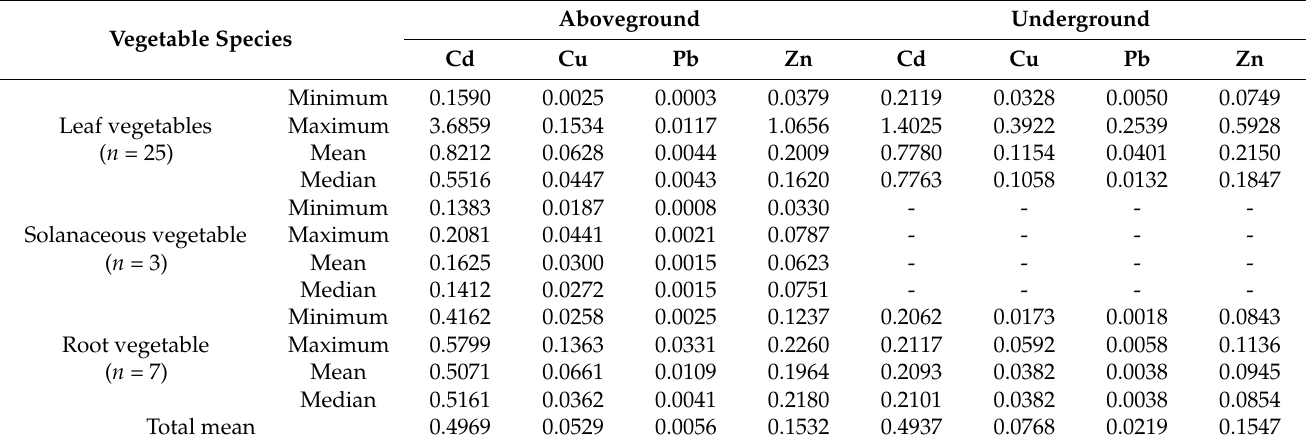
Table 4. Bioaccumulation factors (BCFs) of the heavy metals in different crops ( n =